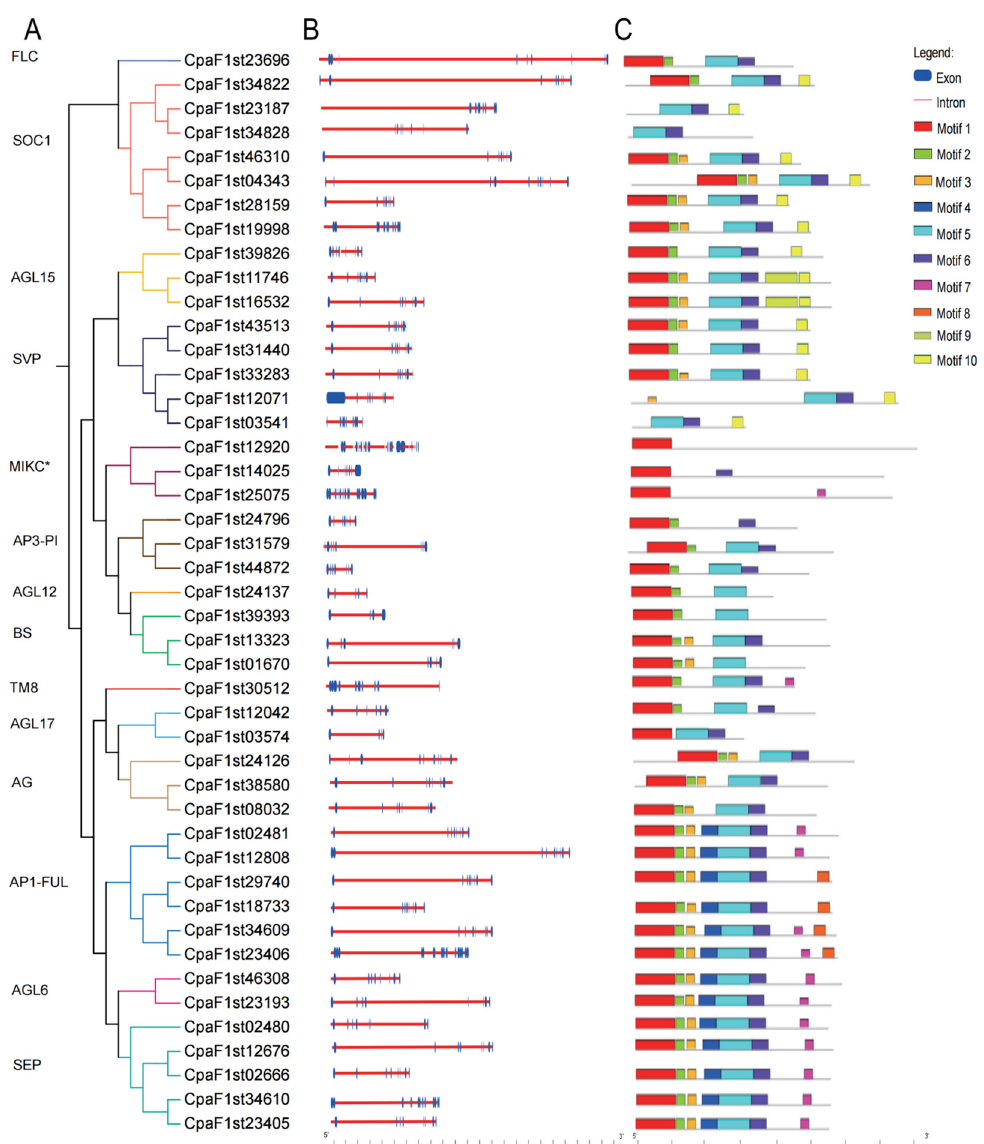
Figure 4. The phylogenetic relationship, gene structure, and motif compositions of MIKC-type MADS-box proteins. ( A ) The phylogenetic relationships of MADS-box proteins based on the NJ method. The various colors characterize the 14 subfamilies. ( B ) Gene structures of the MADS-box gene family was generated on the basis of the gene Structure Display Server. Exons (blue rectangles) and introns (pink lines) are marked along with their sequence length. ( C ) Motif in MIKC-type MADS-box proteins were predicted by MEME. The conserved motifs are represented by different colored boxes.